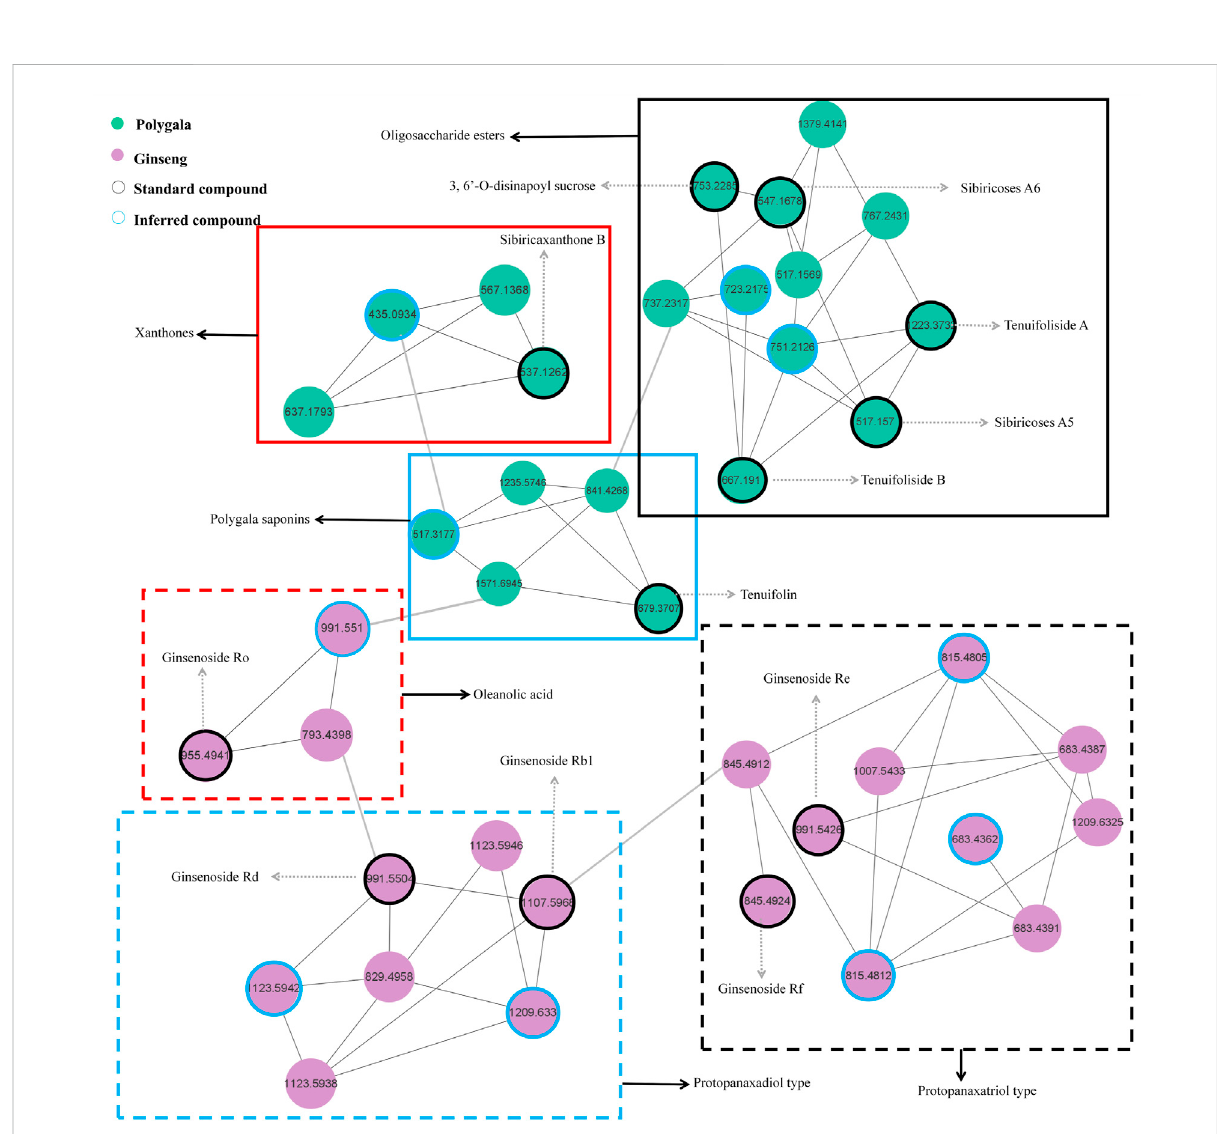
FIGURE 4 The molecular network of characteristic components in “ ginseng – polygala ” drug